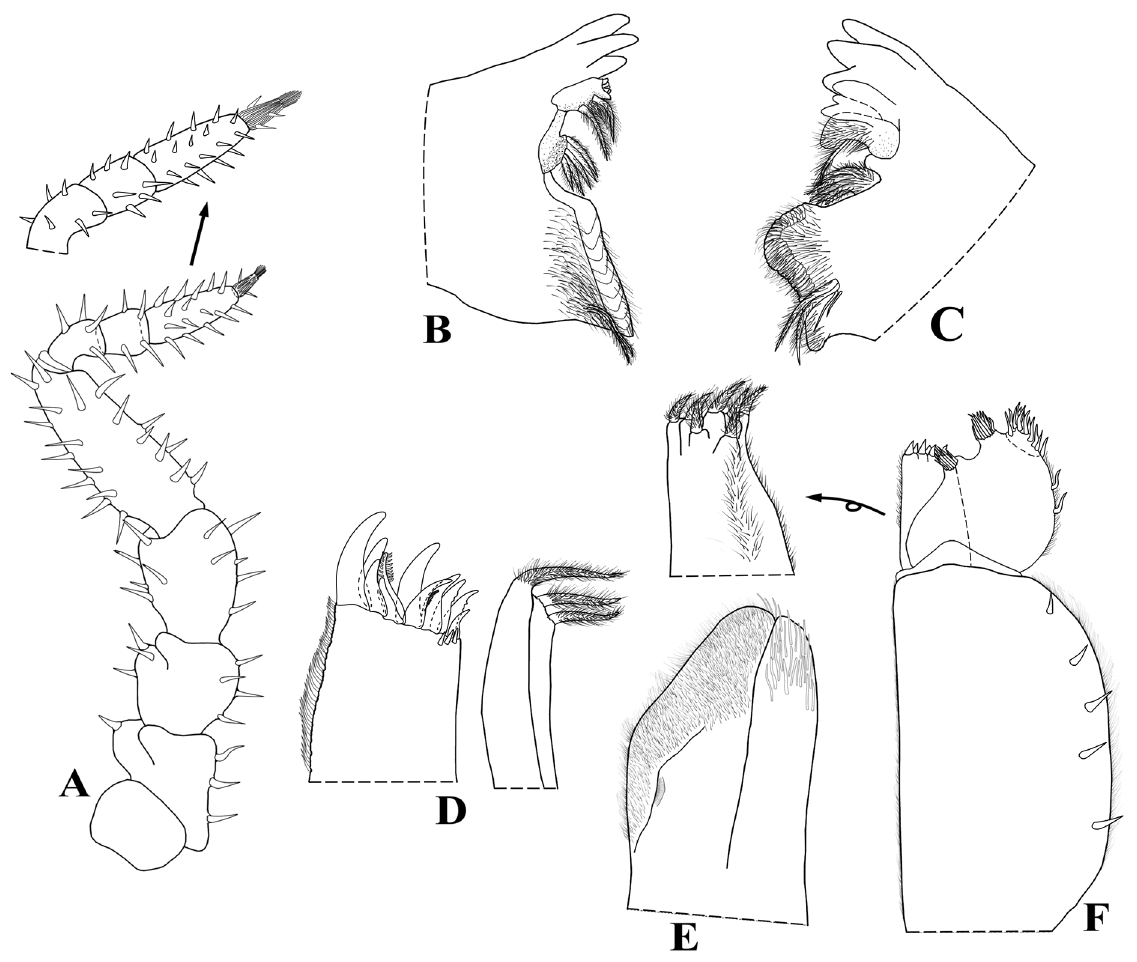
Fig. 4. Tylos negroi López-Orozco, Carpio-Díaz & Campos-Filho sp. nov., paratype, ♀ (CDUC- CRU 129). A . Antenna. B . Left mandible. C . Right mandible. D . Maxillula. E . Maxilla. F .